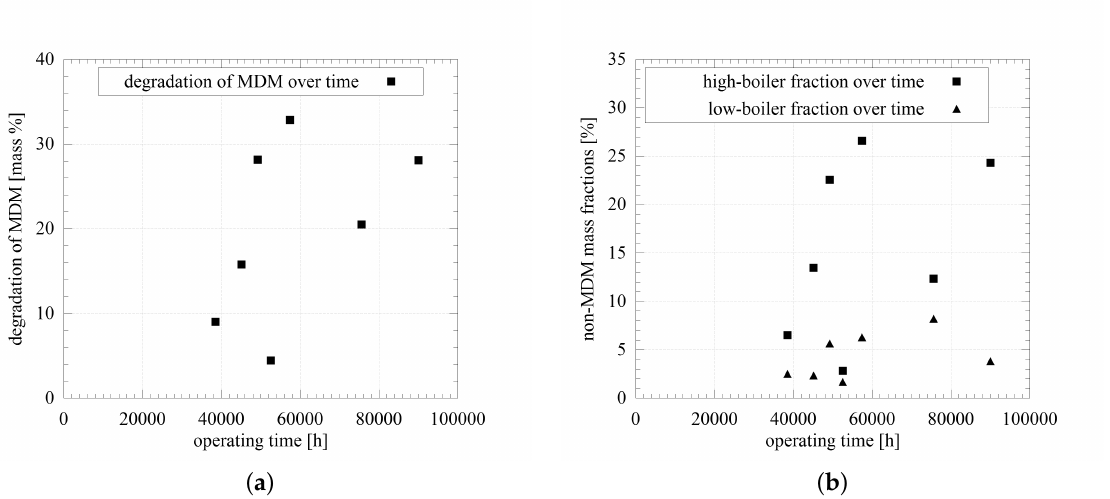
Figure 3. ( a ) High and low boiler fraction in fluid samples versus operating time; ( b ) Degradation of working fluid versus operating time.